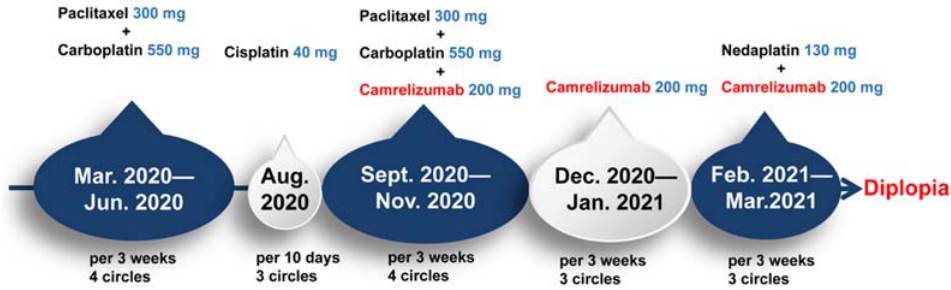
Figure 5. A detailed clinical timeline is displayed. In March 2020, the patient was hospitalized. After a series of examinations, the patient was diagnosed with middle-lower section esophageal cancer with lymph node metastasis. In March 2020, the patient was started on a chemotherapy regimen containing paclitaxel/carboplatin for four cycles. The regimen was subsequently switched to Cisplatin for three cycles. From September 2020, Camrelizumab was arranged in ten cycles with or without the combination of chemotherapy. The horizontal diplopia was onset in April 2021.